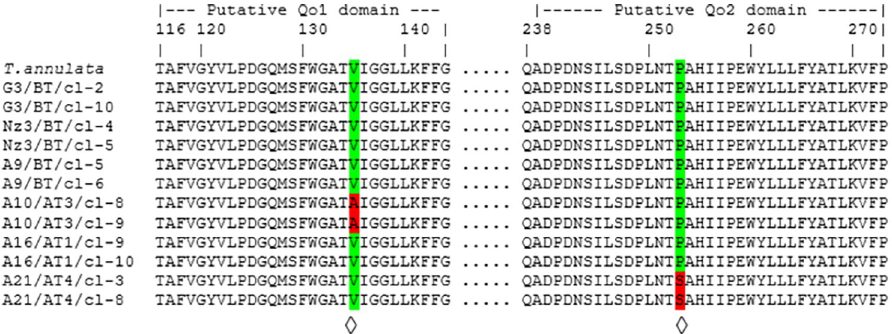
Fig 3. Alignments of putative Q o1 and Q o2 domains of Cyto b . Predicted amino acid sequences of Q o1 and Q o2 domains encoded by the Cyto b gene from the published T . annulata / C9 genome sequence and different T . annulata isolates with treatment failure history. Putative Q o1 and Q o2 domains are located between 116–144 and 238–273 amino acids of the protein around the ubiquinone binding site. Predicted amino acid substitutions associated with buparvaquone resistance are marked with ^